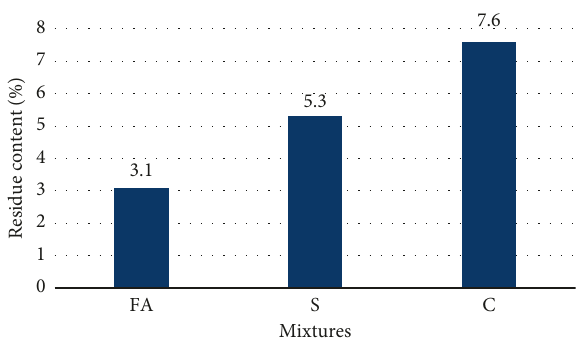
Figure 4: Mixing stability test results of new mixtures.